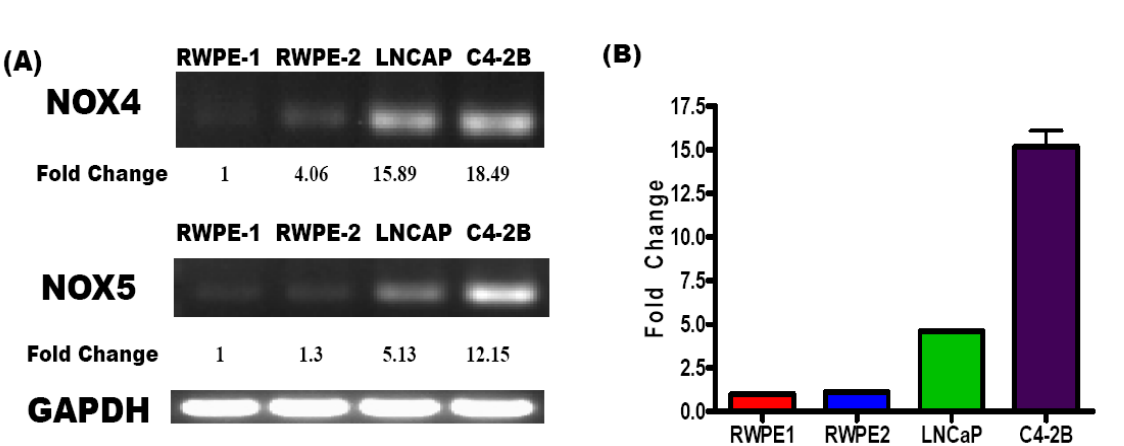
Figure 1. NOX4 and NOX5 mRNA Expression in a Prostate Cancer Progression